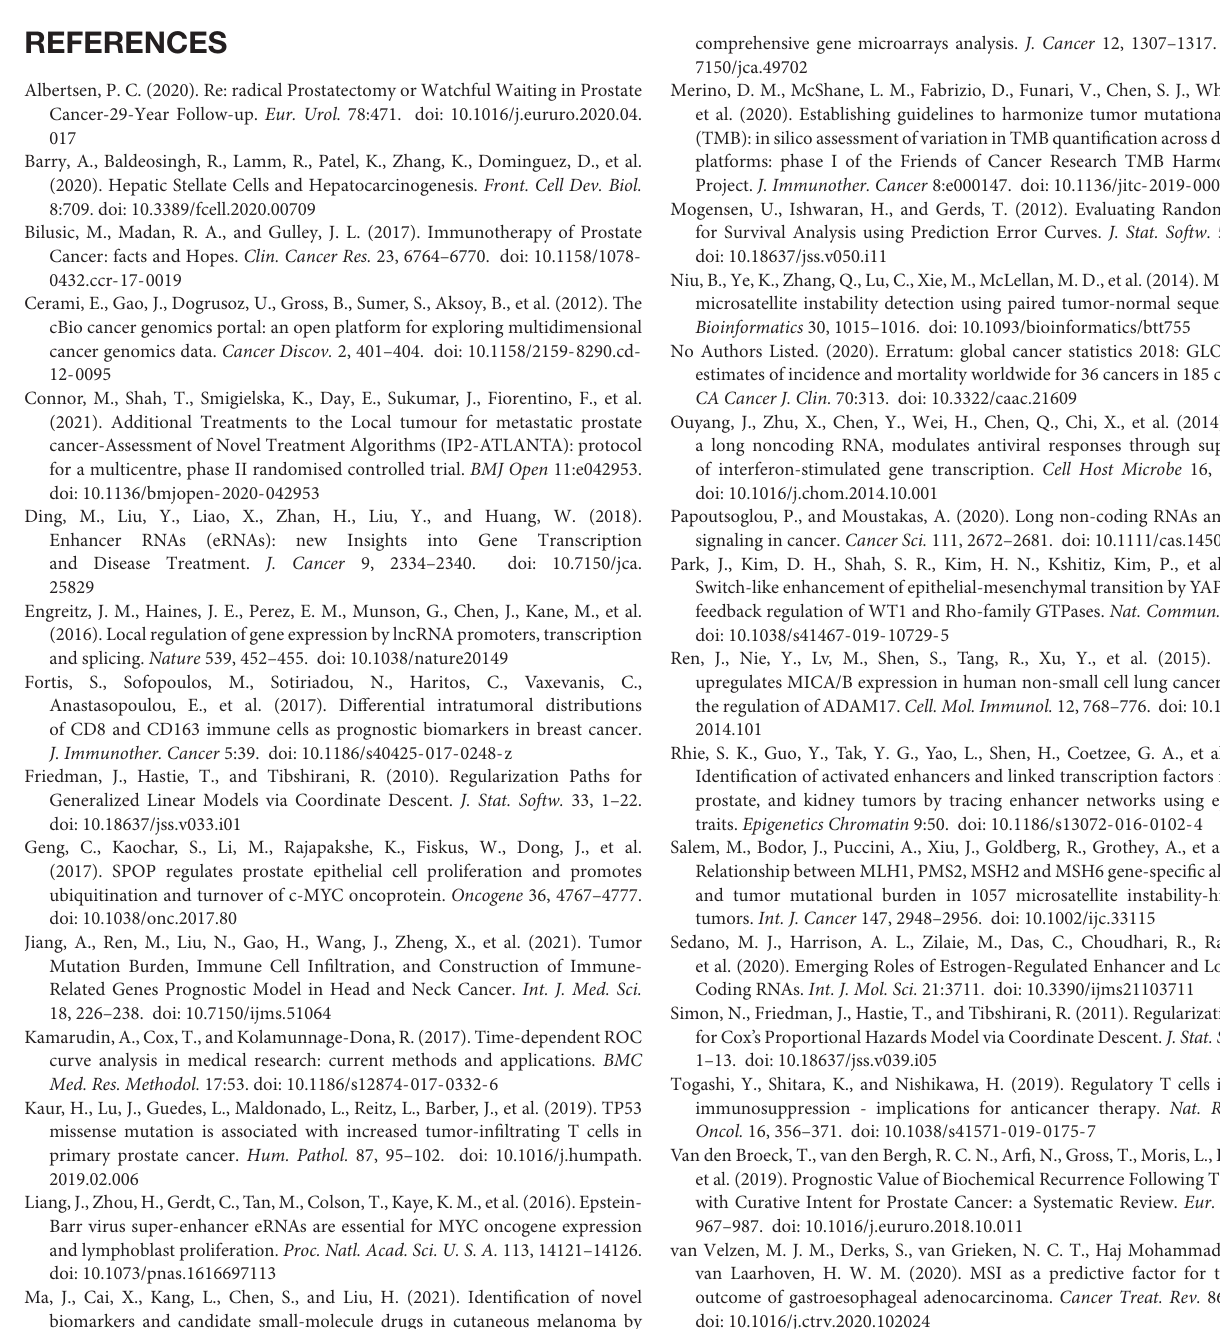
Supplementary Table 2 | Functional markers of nine eRNAs-driven genes. Supplementary Table 3 | Clinical factors were analyzed by univariate and multivariate Cox. Supplementary Table 4 | 130 GO terms of differential expression